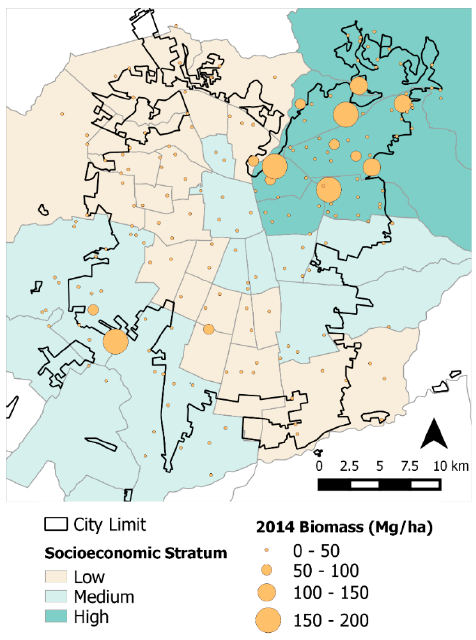
Figure 2. Aboveground tree biomass distribution in Santiago, Chile in 2014. Larger sized circles represent plots with higher biomass estimates.